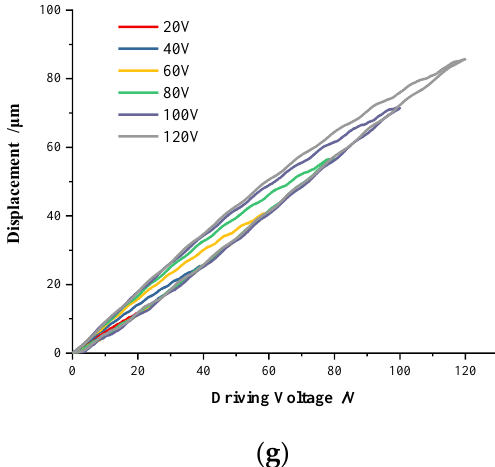
Figure 4. Hysteresis on variable voltages. ( a ) 0.1 Hz; ( b ) 0.5 Hz; ( c ) 1 Hz; ( d ) 2 Hz; ( e ) 5 Hz; ( f ) 10 Hz; ( g ) 20 Hz;